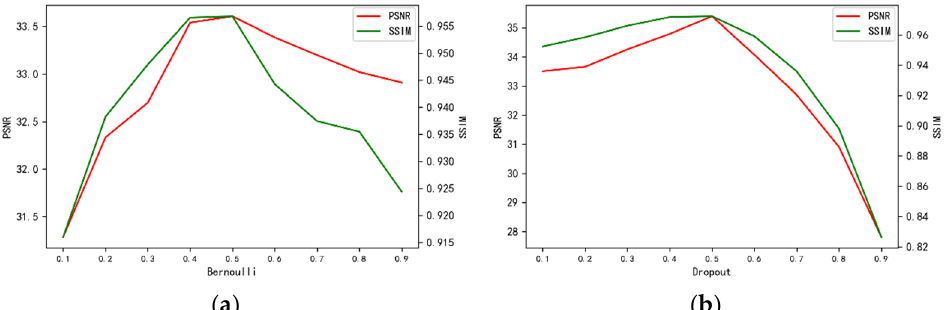
Figure 19. The ( a ) Bernoulli sampling and ( b ) dropout probability hyperparameters. Number of iterations